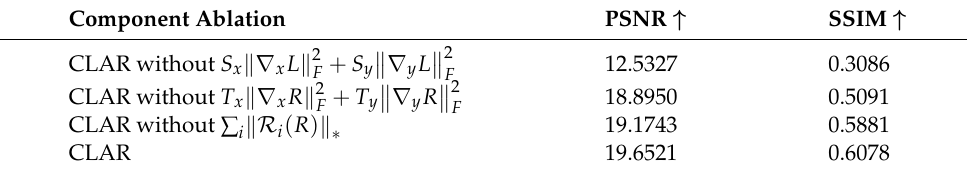
Table 1. Quantitative evaluation in terms of PSNR ↑ and SSIM ↑ metric for ablation test.